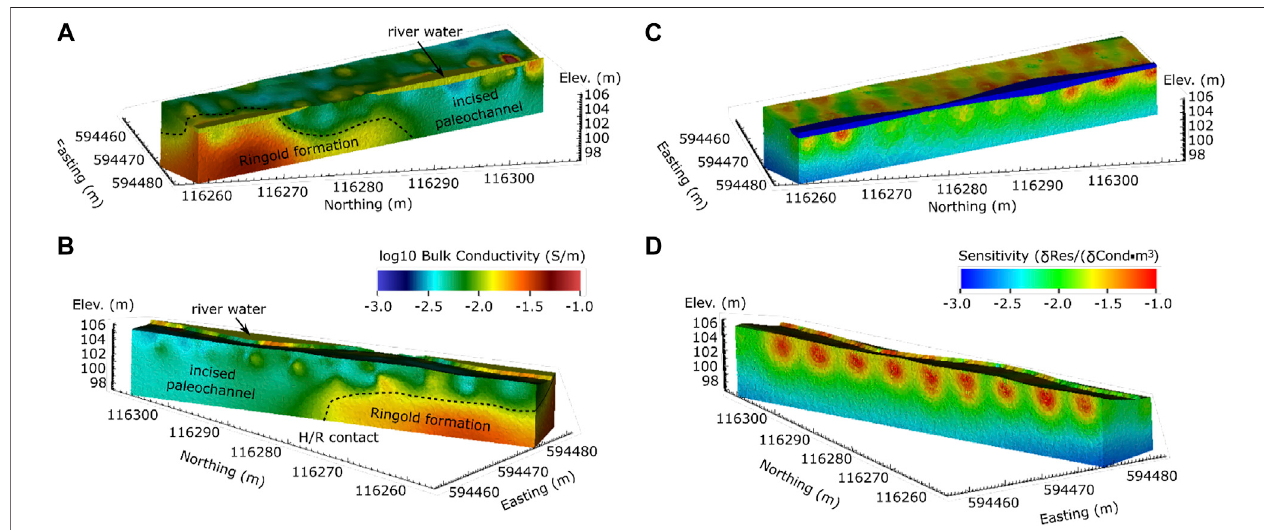
FIGURE 6 | (A) View of baseline inversion from river facing westward. (B) View of baseline inversion from shoreline facing northeast. (C) View of data sensitivity to bulk conductivity from river facing westward. (D) View of data sensitivity to bulk conductivity from shoreline facing northeast.